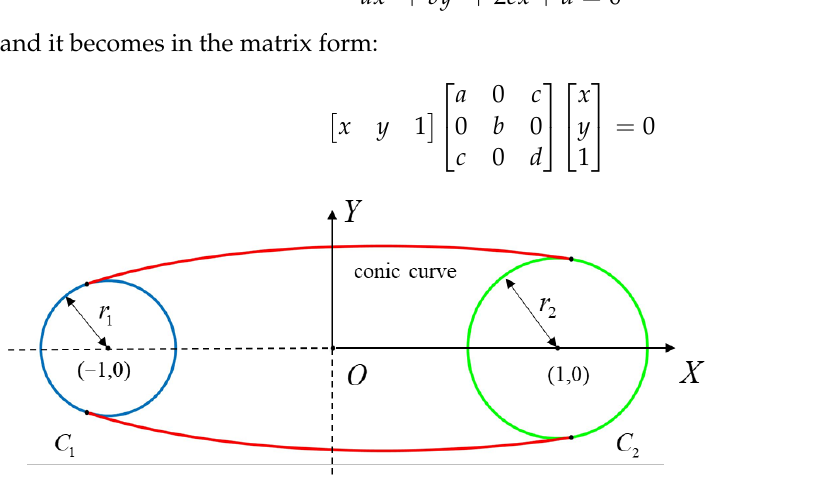
Figure 9. Construction of variable truss-like strut.